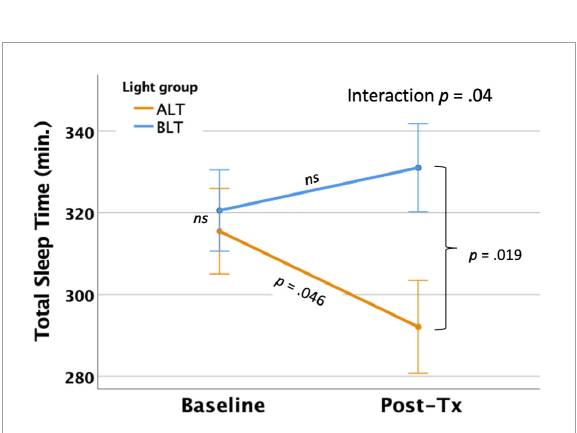
FIGURE3 Six weeks of blue light treatment (BLT) was associated with significantly greater actigraphically measured total sleep time (TST) than an equal period of amber light treatment (ALT), p = 0.042. Orange line = ALT; Blue line = BLT. Error bars = ± 1 SE. Post hoc comparisons are Bonferroni corrected.